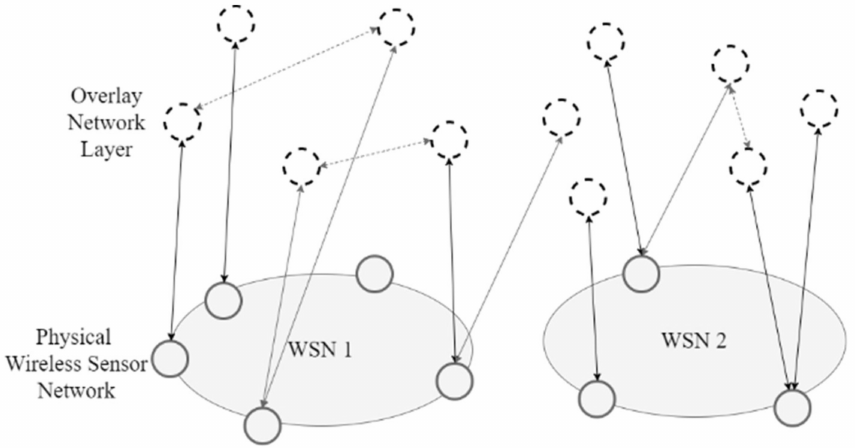
Figure 9. Peer-to-peer overlay